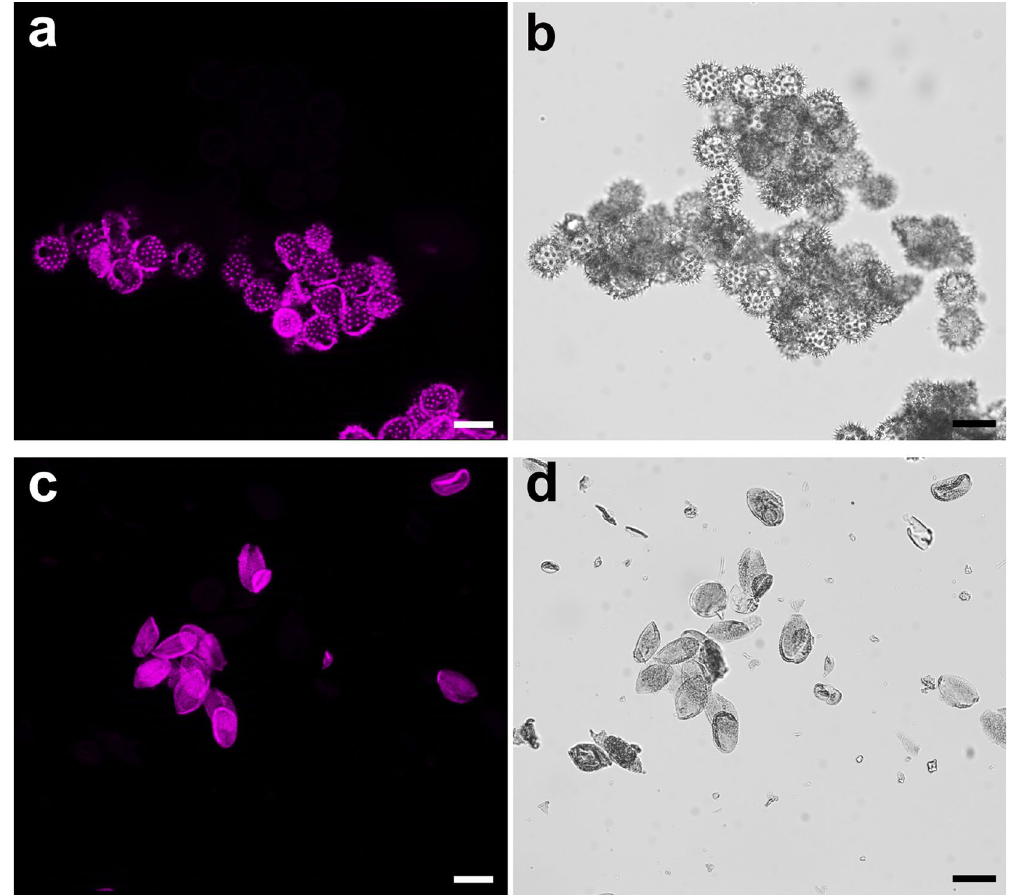
Figure 3. Fluorescence imaging of mixed samples of sporopollenin grains with and without fluorescent coating. Sunflower ( a , b ) and Rape ( c , d ) sporopollenin exine shells with and without RBITC coating. By using mCherry filtercube ( a , c ), only the coated grains can be shown, while the non-coated ones are glowing only weakly. Brightfield image ( b – d ) shows all of the grains.